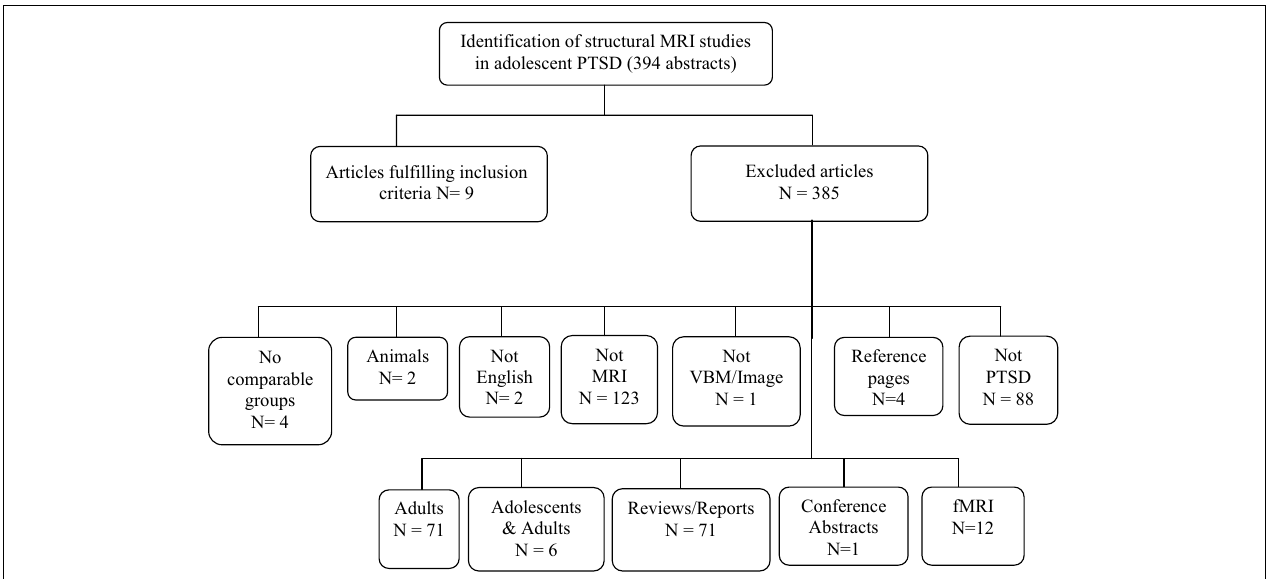
FIGURE 2 |Article selection process of structural magnetic resonance imaging studies in posttraumatic stress disorder in children and adolescents.